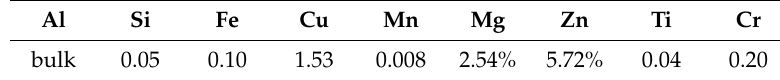
Table 1. Chemical composition (% weight) of the alloy 7075-T6.